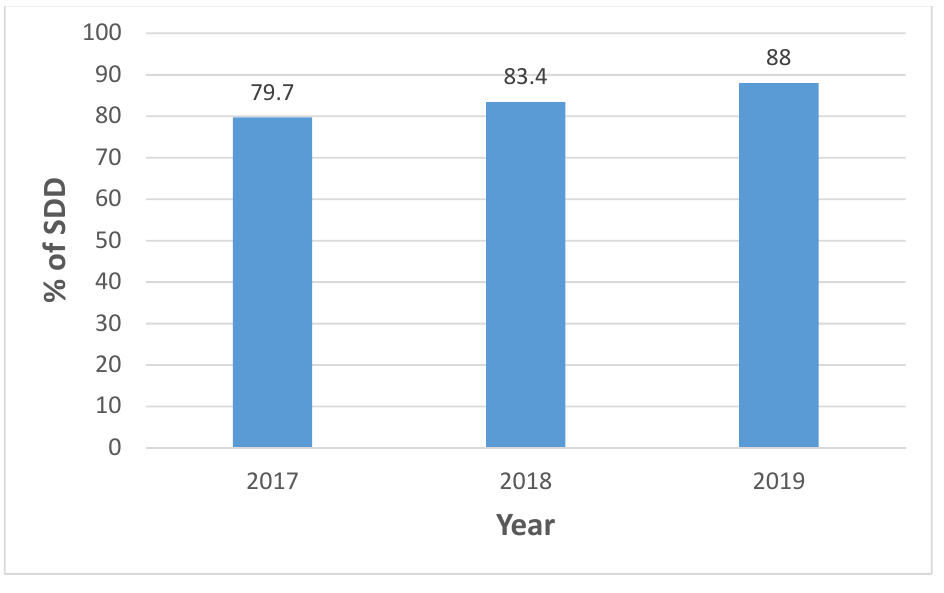
Figure 1. Percentage of SDD in all elective PCI patients from 2017 to 2019. Table 3. Hospital LOS following inpatient admission post PCI by